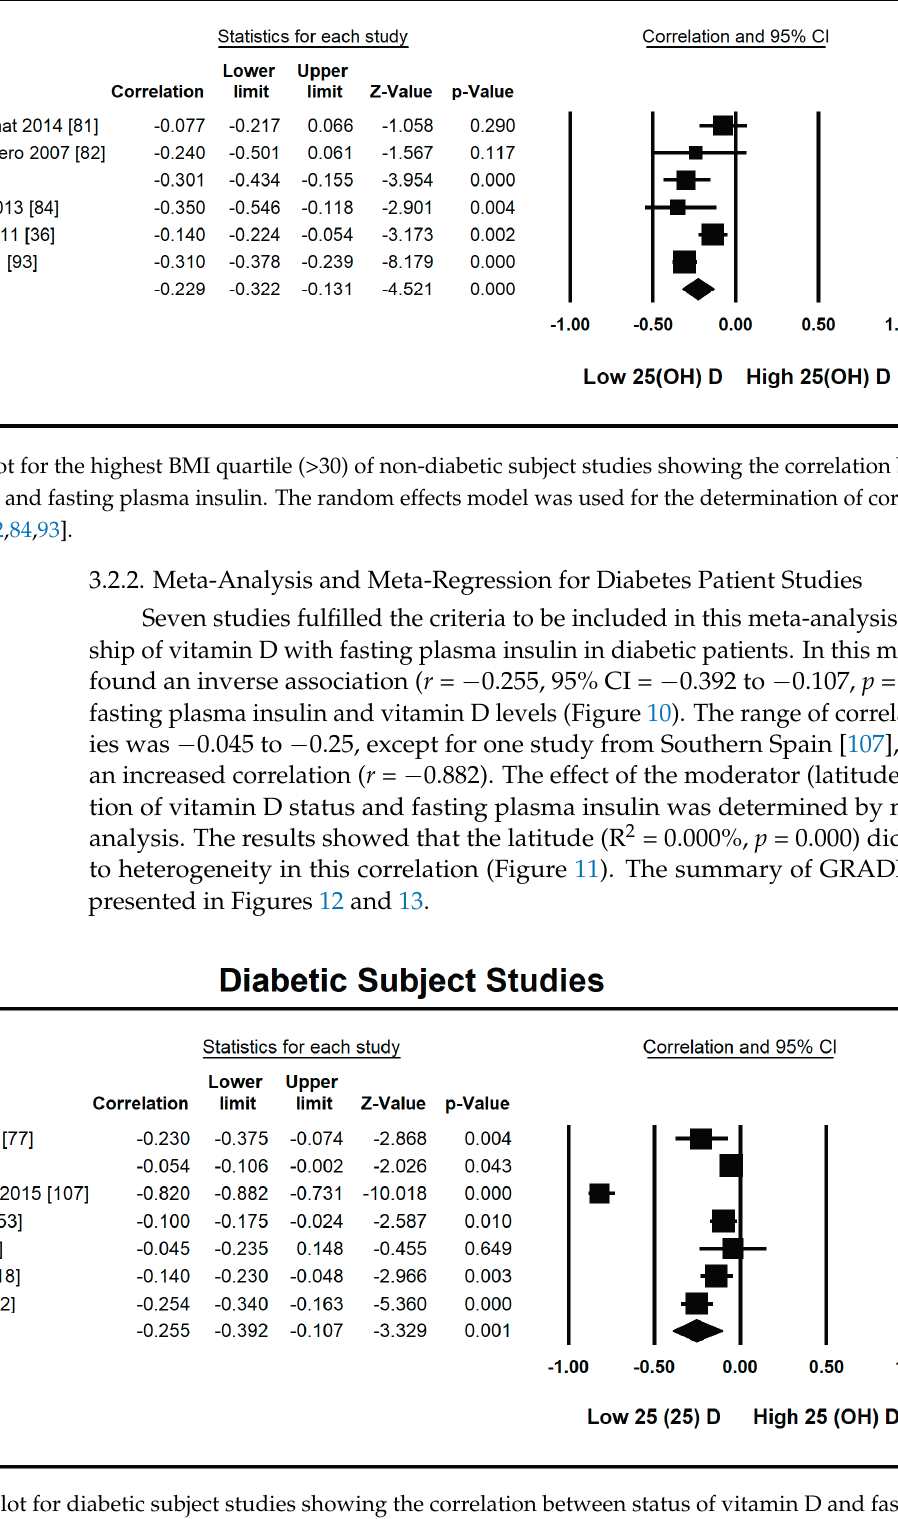
Figure 11. Meta regression analysis for diabetic subject studies. Latitude R 2 shows the effect of the moderator on the het- erogeneity of correlation. ( a ) total variance in true effects; ( b ) not explained by model; ( c ) explained by model.